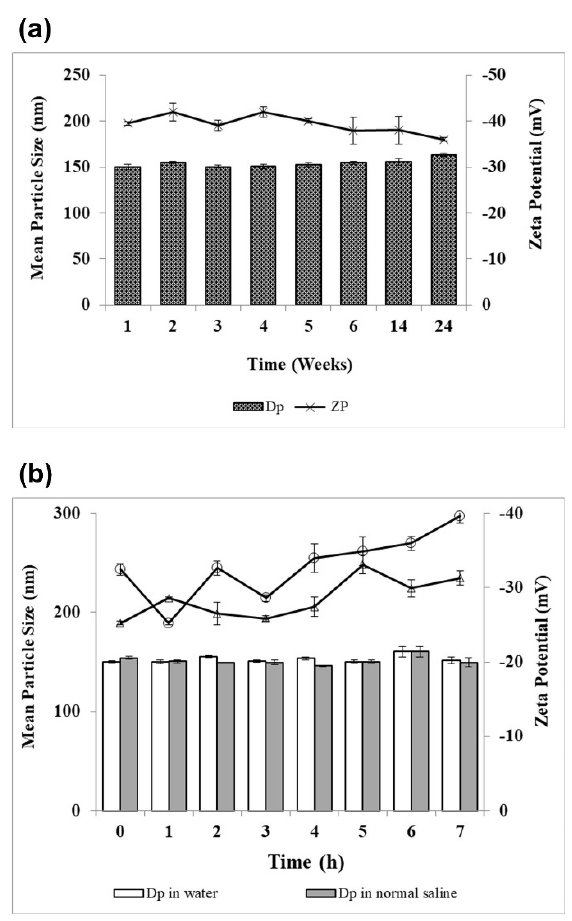
Figure 9. Physical stability of artemether-loaded zein nanoparticles. ( a ) Particle size (DP) and zeta potential (ZP) analyses of artemether-loaded zein nanoparticles powder on storage at 4 °C and relative humidity of 75 ± 5% for 24 weeks; ( b ) particle size and zeta potential analyses of artemether- loaded zein nanoparticles after reconstitution with water and with normal saline. All experiments were carried out in triplicate ( n = 3); symbols represent mean values while error bars represent SD.